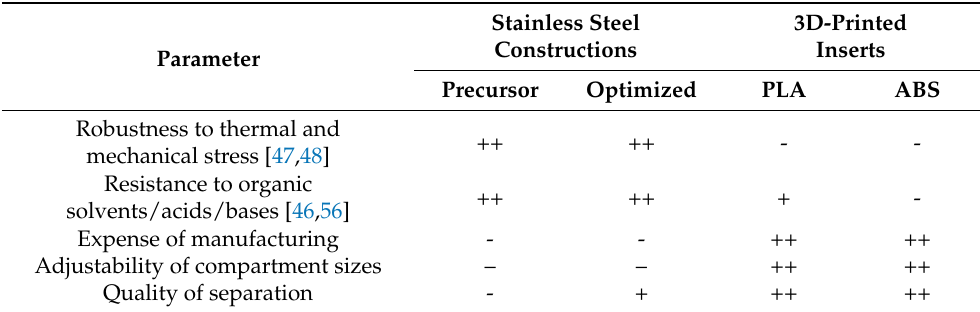
3D-Printed Inserts